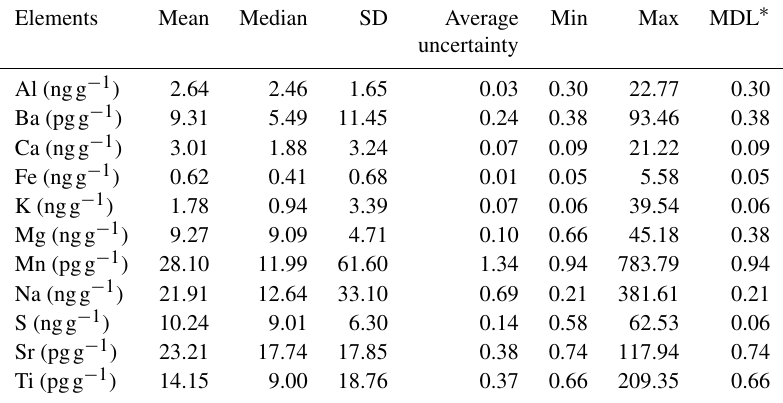
Table 1. Statistical summary of trace elements concentrations determined in the MJ ice core. Elements Mean Median SD